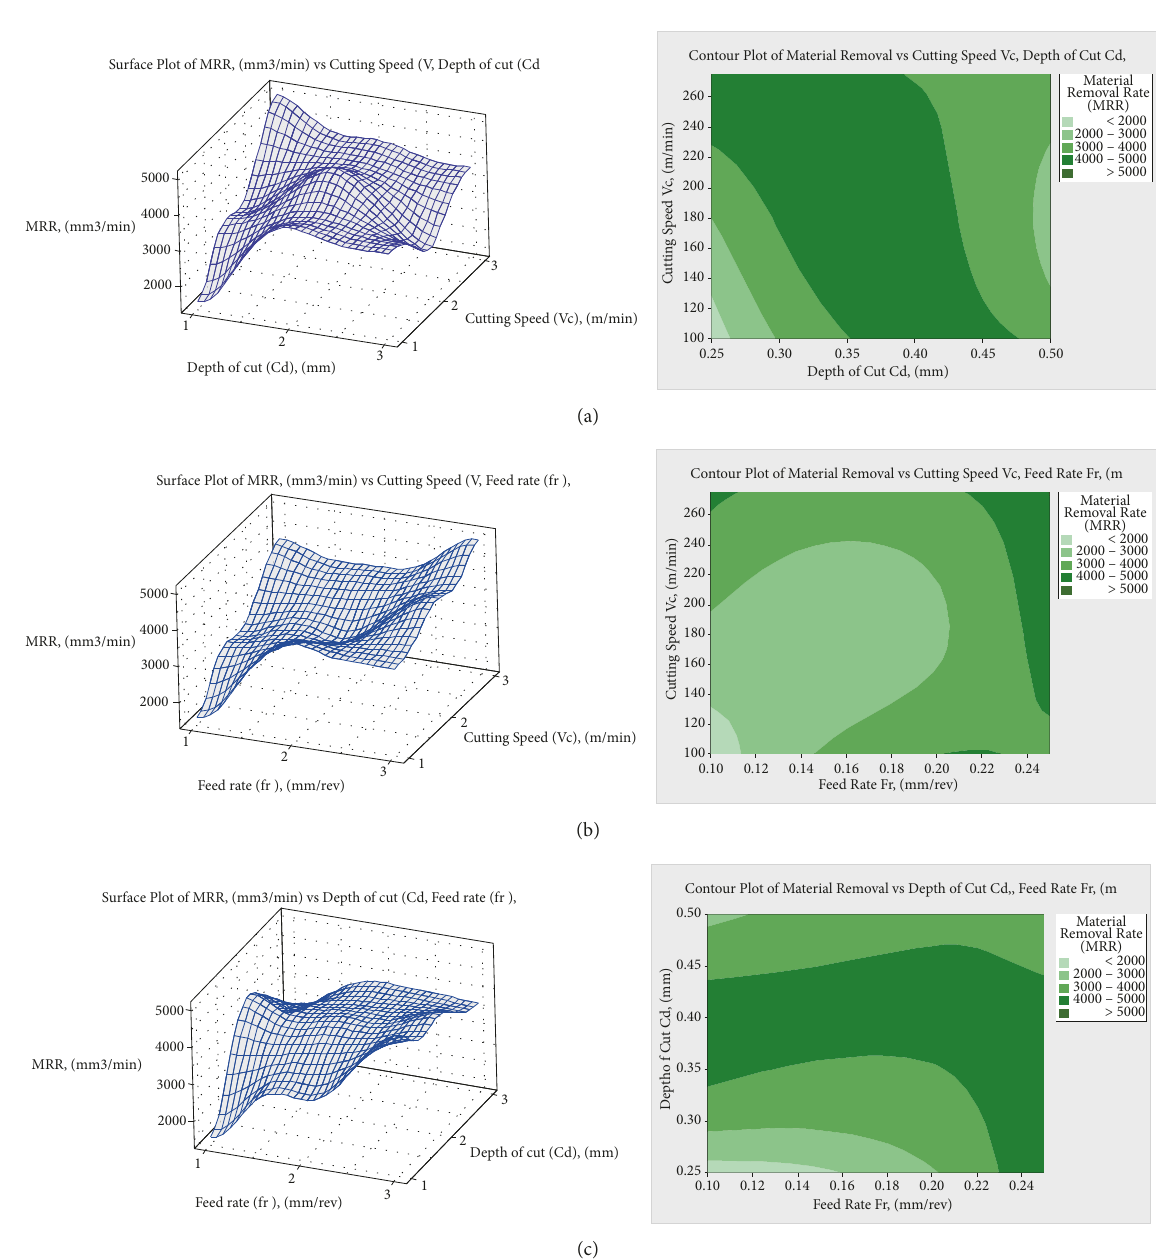
(c) Figure 5: 3D surface and contour plots for turning process control factors versus MRR (mm 3